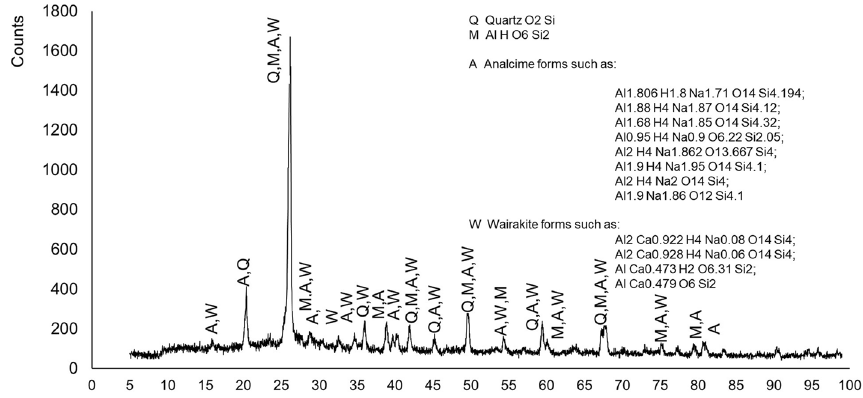
Fig. 9 X-ray diffraction analysis test results for 2% lime content fly ash geopolymer mortar after steam curing for 2 days